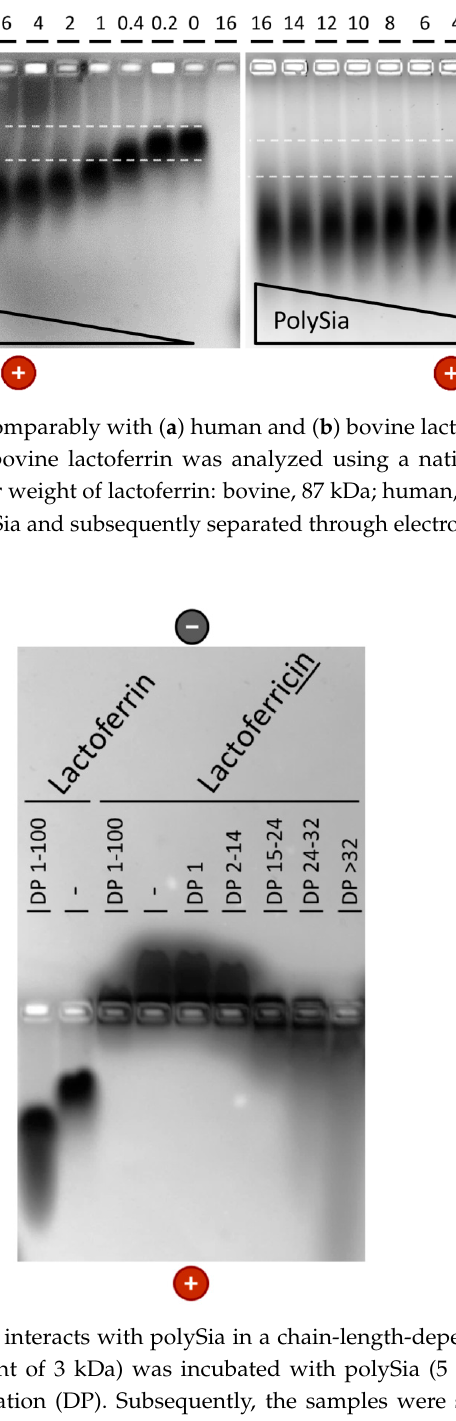
Figure 4. Lactoferricin (LFcin) interacts with polySia in a chain-length-dependent manner. Bovine LFcin (10 µg; molecular weight of 3 kDa) was incubated with polySia (5 µg) using groups with different degree of polymerization (DP). Subsequently, the samples were separated using native agarose gel electrophoresis. As positive control, lactoferrin was used (10µg). Proteins were stained with Coomassie blue.